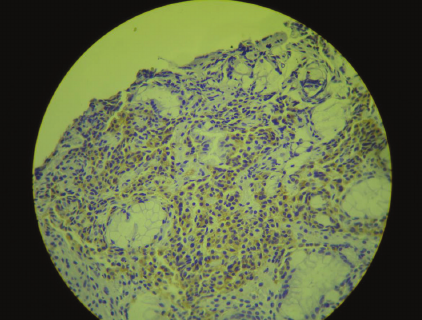
Figure 7: Platelet count after discontinuation of